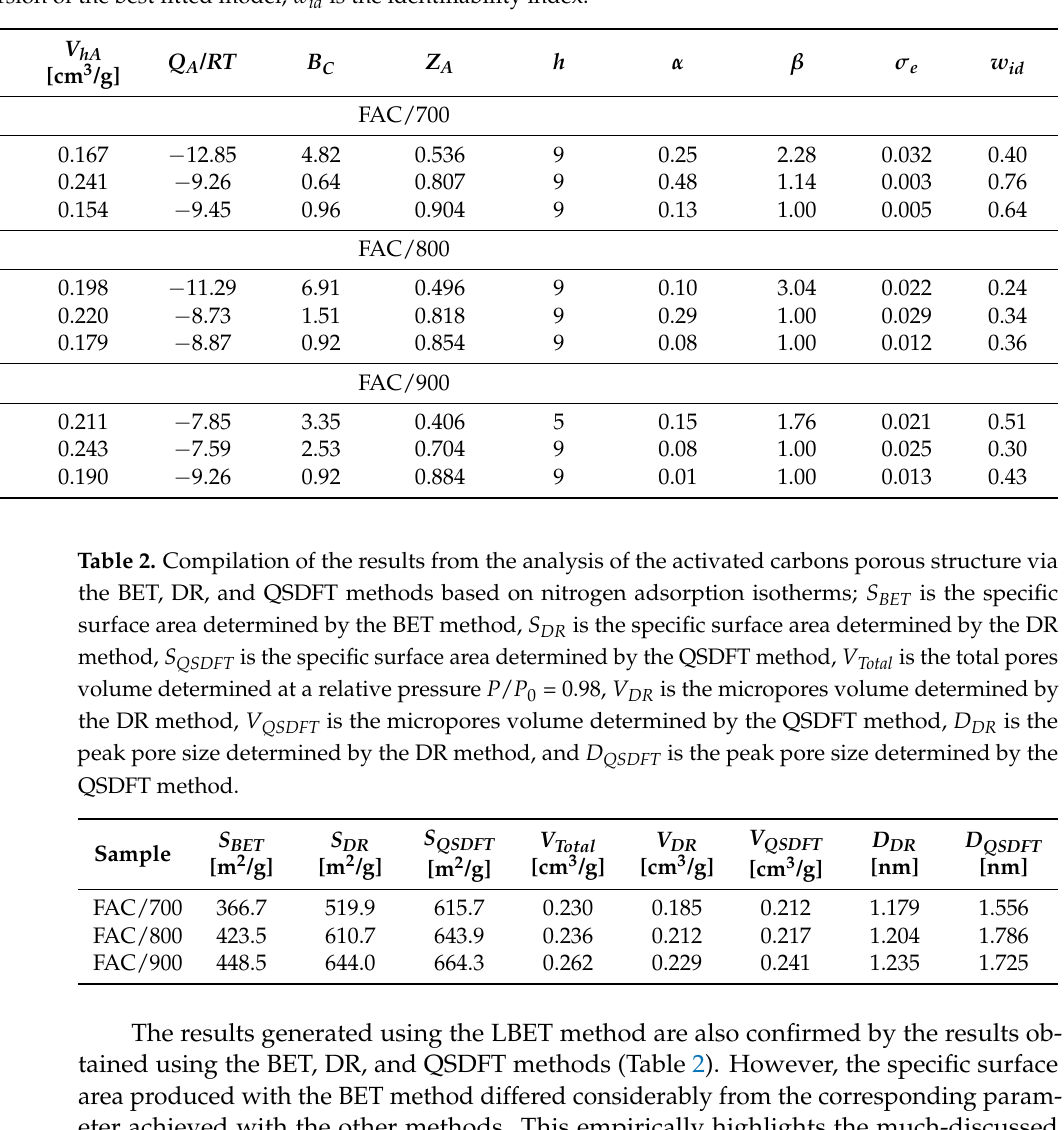
Table 1. Compilation of the results from the analysis of the activated carbons derived from the leaves of common polypody porous structure via the LBET method based on nitrogen, carbon dioxide, and methane adsorption isotherms; LBET No. is the number of the best fitted LBET class model; V hA is the volume of the first adsorbed layer; Q A / RT is the energy parameter for the first adsorbed layer; B C is the energy parameter for the higher adsorbed layers; α is the parameter of the porous structure determining the height of the adsorbate molecules clusters; β is the parameter of the porous structure determining the width of the adsorbate molecules clusters; Z A is the effective contact correction factor; h is the heterogeneity parameter; σ e is the error dispersion of the best fitted model; w id is the identifiability index.